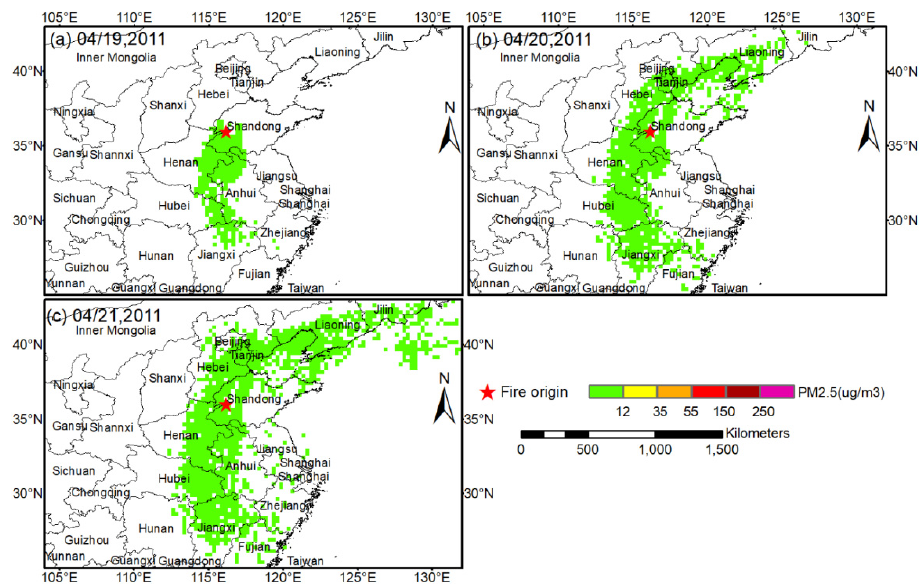
Figure A7. Same as Figure A1 except for the Jinan fire. Panels ( a – c ) are 19, 20, and 21 April 2011, respectively.